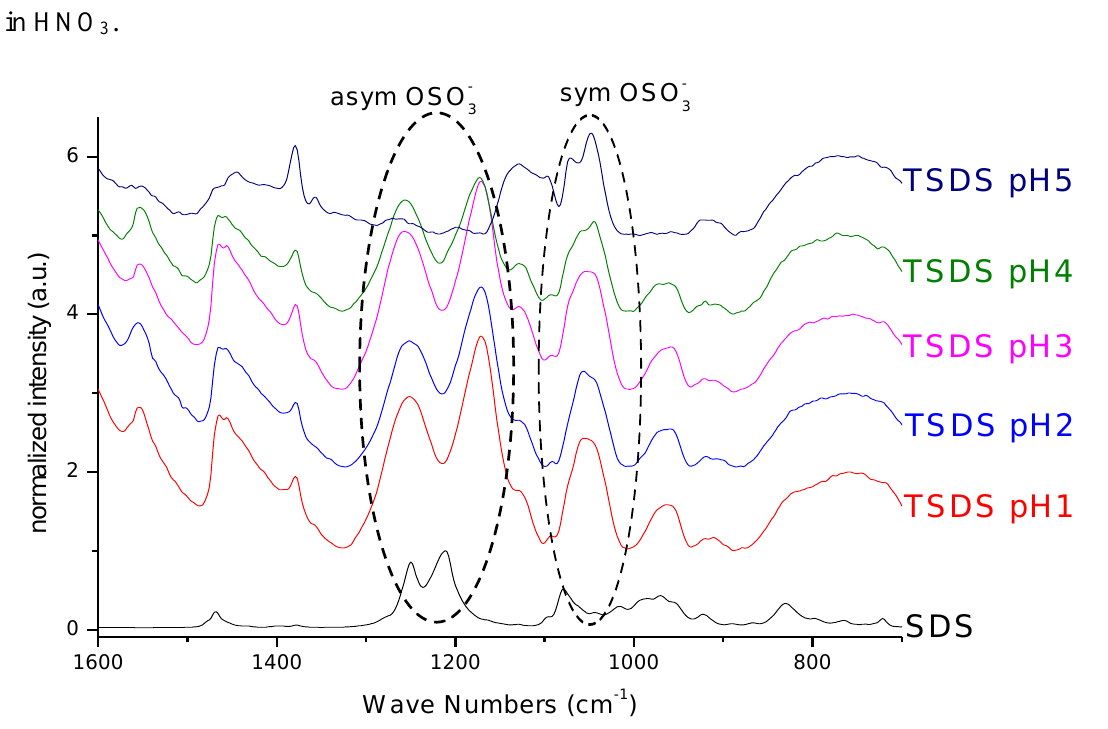
functionalized at pH 1, 2, 3, 4 and 5 2